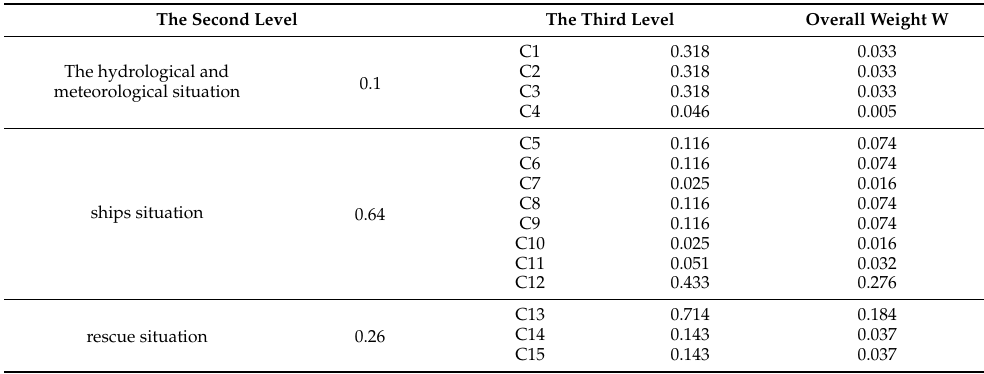
Table 5. Subjective weights of all